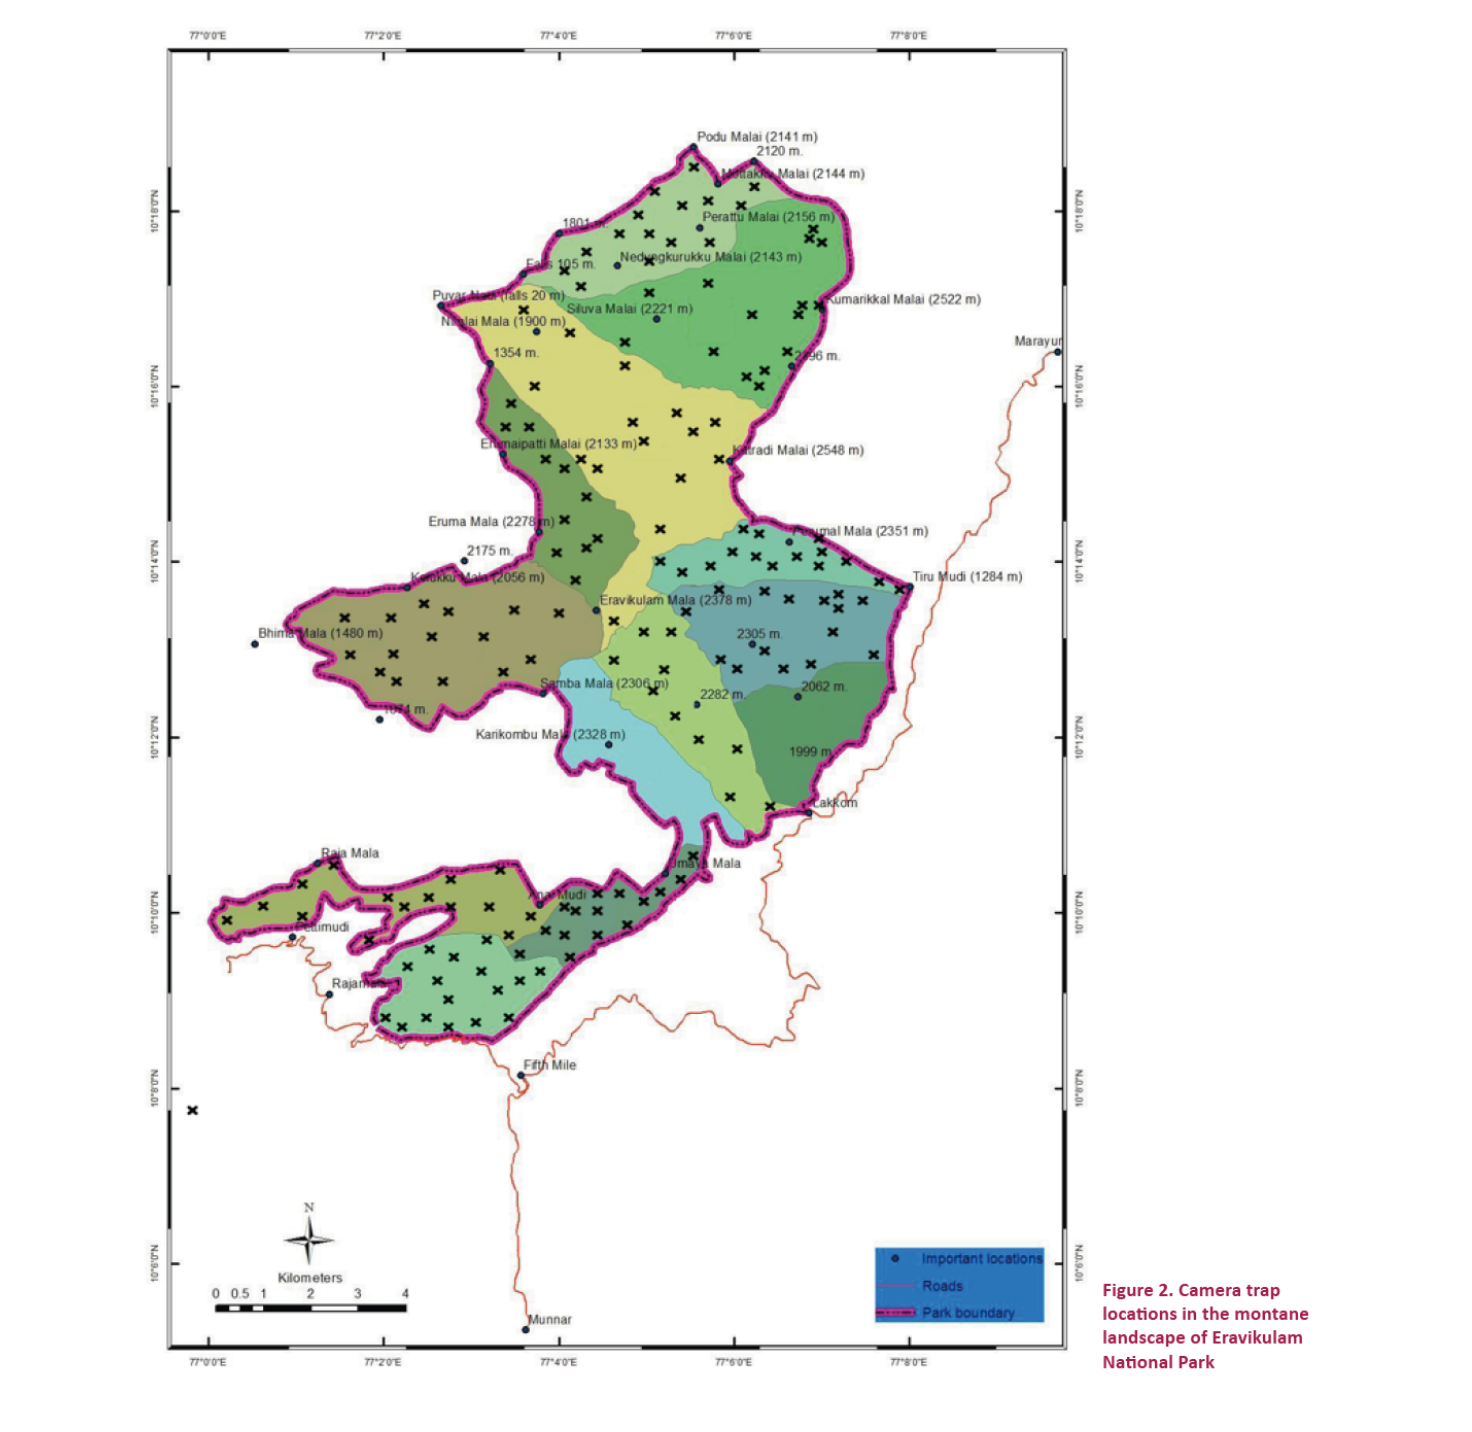
Ffigure 2. Camera trap locafions fin the montane landscape off Eravfikulam Nafional